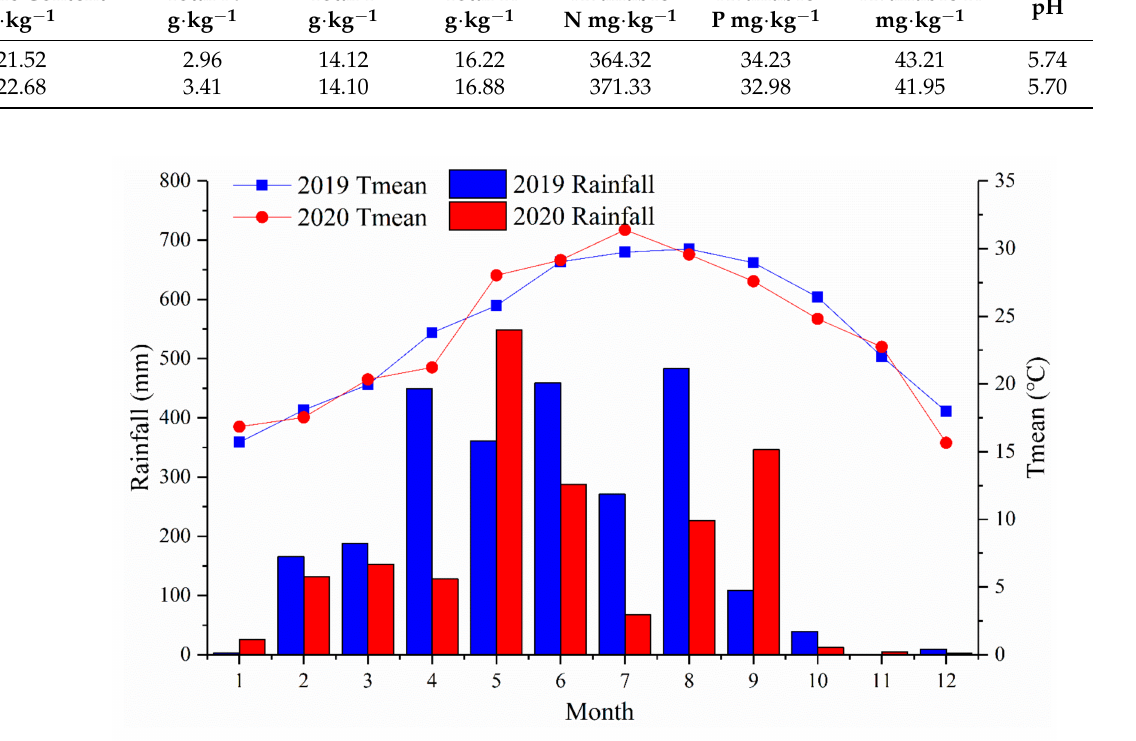
Figure 1. Temperature and rainfall trend during 2019 and 2020 at SCAU experimental